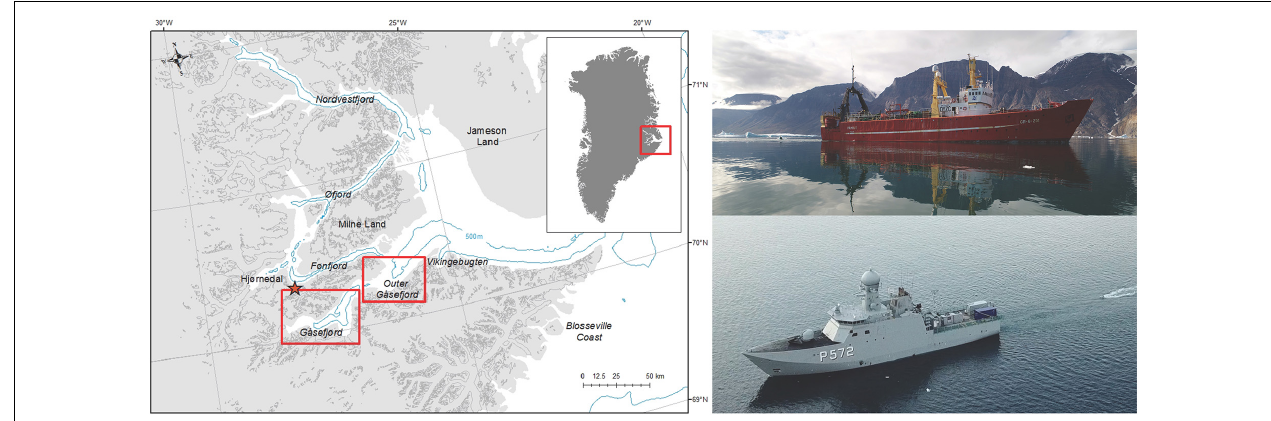
FIGURE 1 | Map of study area in Scoresby Sound ( left ) with locality names and red boxes indicating trial areas shown in Figures 3 , 4; the inset shows the location of the study area in East Greenland. The blue line is the 500-m isodepth. The upper right panel shows r/v Paamiut , and the lower right panel shows HDMS Lauge Koch , both while towing their respective airgun